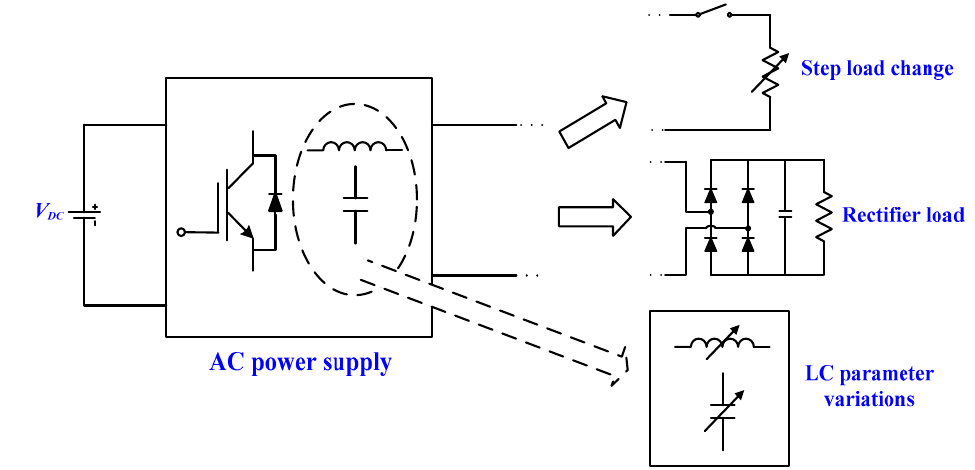
Figure 8. Experimental tests under different load situations.